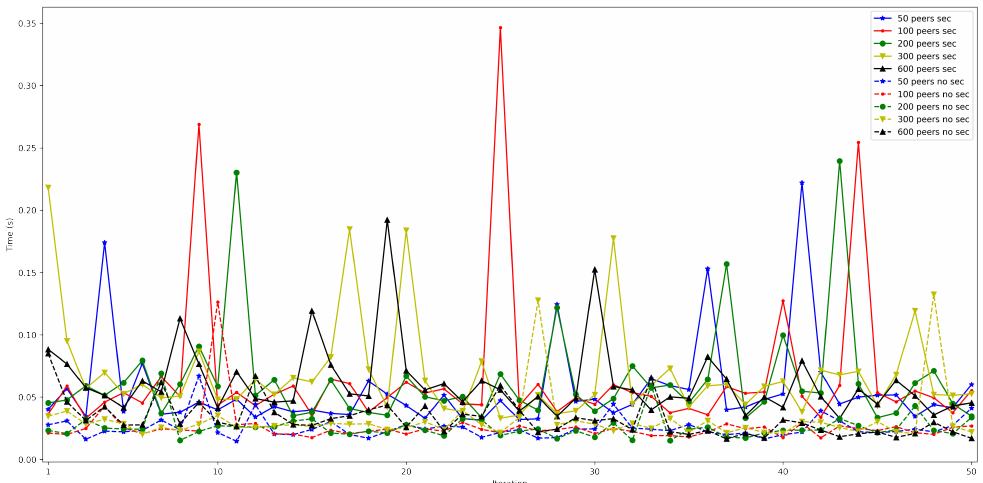
Figure 28. Put time when enabling/disabling TLS 1.3.